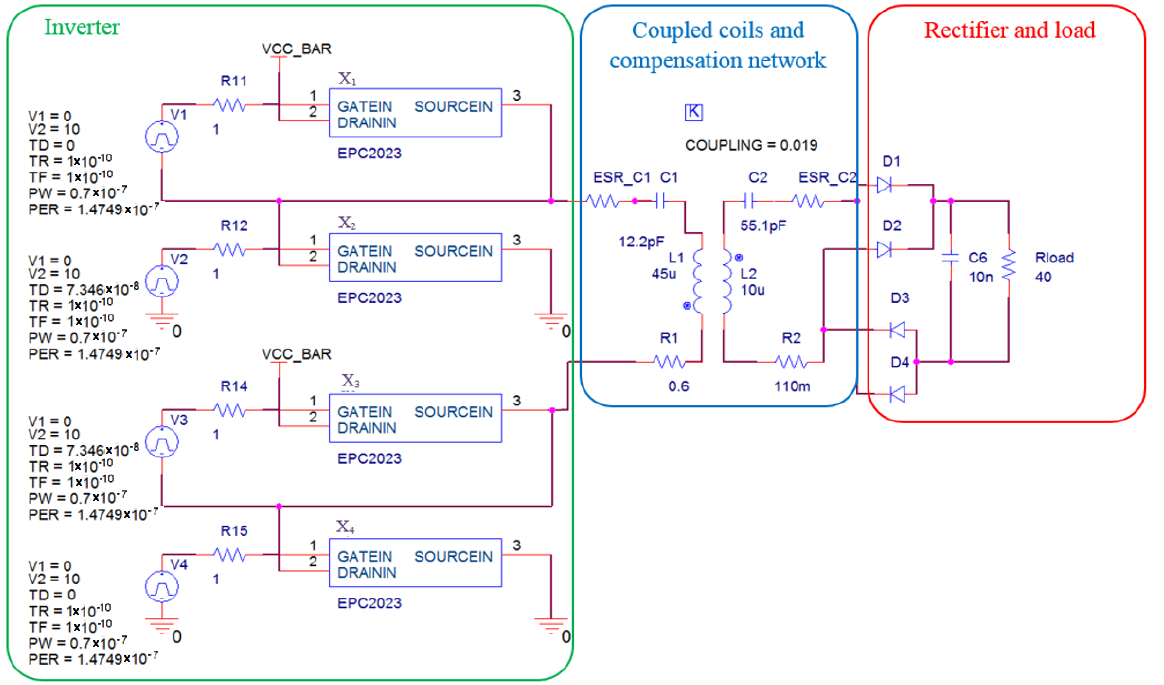
Figure 12. Equivalent circuit with electronic components.